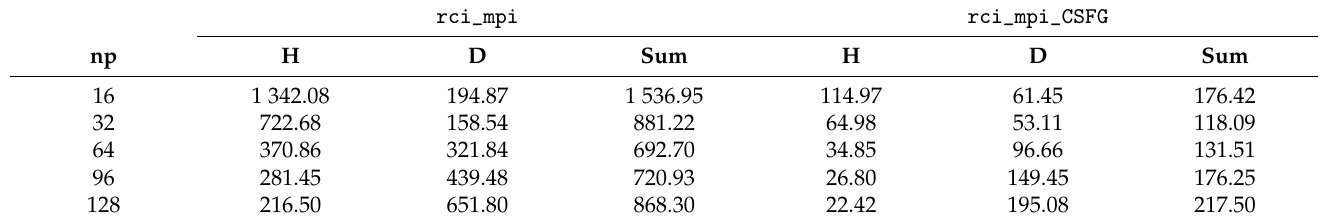
Table 6. CPU times (in s) for the construction of the Hamiltonian matrix (H), its diagonalization (D), and for the cumulated tasks (Sum) using rci_mpi and rci_mpi_CSFG for the 2 + block Mg VII calculations, as a function of the number of MPI processes ( np ).